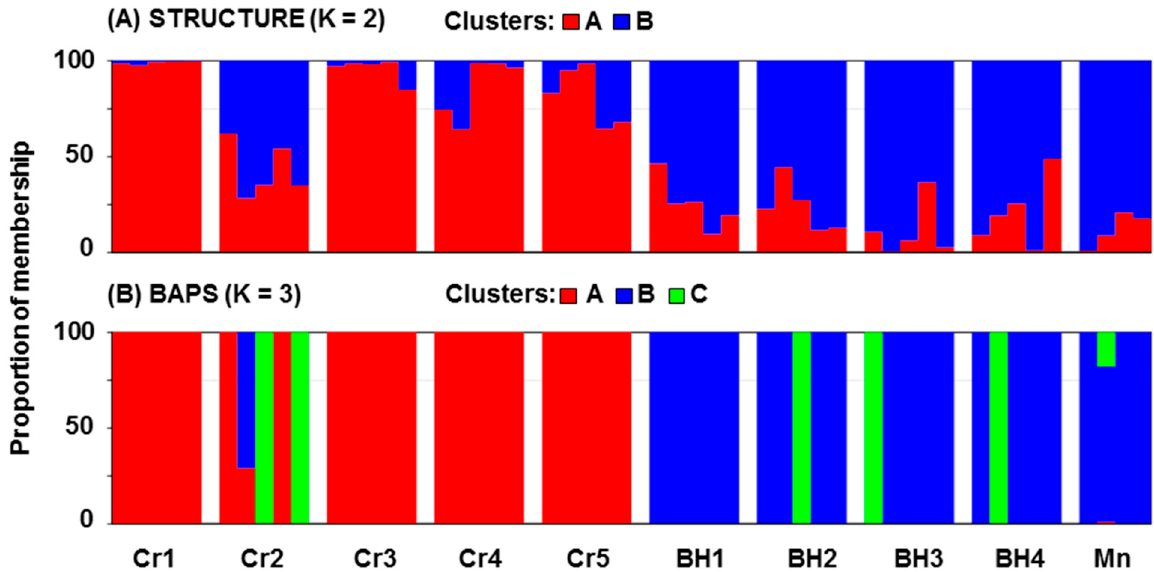
Figure 3. Genetic structure of the investigated populations of Micromeria croatica from Croatia (Cr1–Cr5), Bosnia and Herzegovina (BH1–BH4), and Montenegro (Mn) based on AFLP markers as resolved by Bayesian clustering. STRUCTURE assumes two clusters ( A ) while BAPS assumes three clusters ( B ).